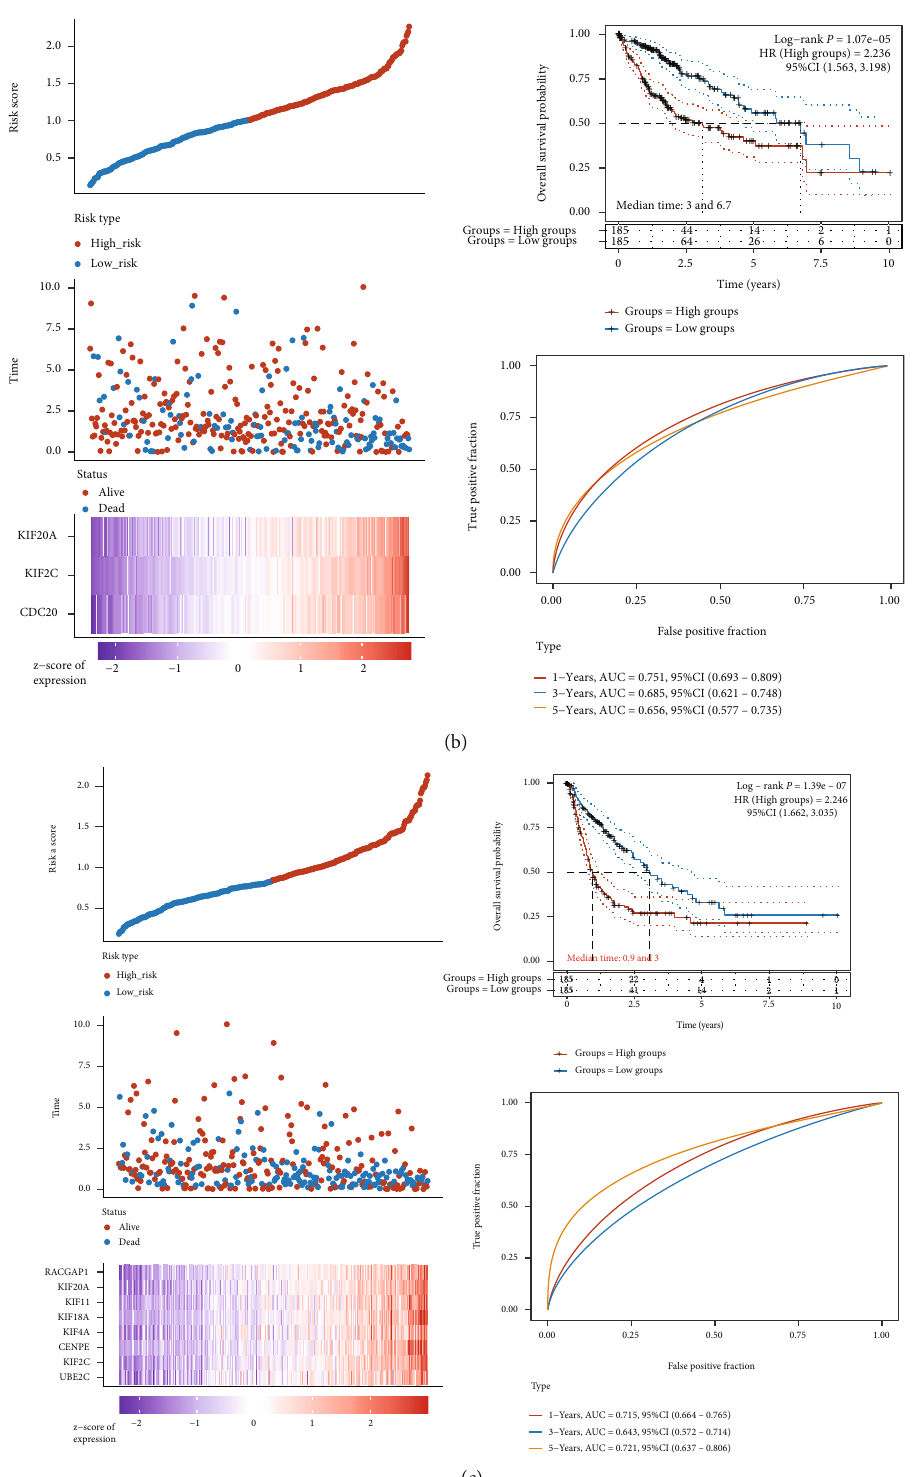
Figure 7: GSEA analysis of PRC1 co-expressing genes and the prognostic signature of immune system-related genes. (a) Identi fi cation of enriched gene sets by GSEA analysis: kinesins; immune system; PLK1, FOXM1, and Aurora B pathway; cell cycle; and RHO GTPase. OS analysis (b) and PFS analysis (c) of the gene signatures which were associated with the immune system according to the GSEA analysis. The left panel showed the curve of risk score, survival status of the patients, and the heat map of the expression pro fi les of the prognostic genes in the low- and high-risk group. The right upper panel showed the Kaplan-Meier survival analysis of the gene signature. The right lower panel showed the time-dependent ROC analysis of the gene